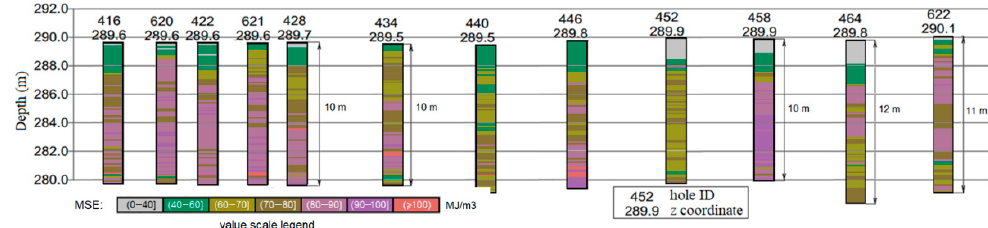
Figure 11. MSE profile in the area of boreholes No. 416–428 in block No. N 58–70 with depth positioning.